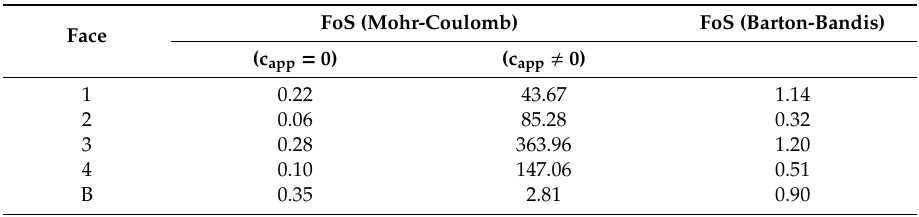
Table 9. FoS values obtained considering the presence of seismic action with respect to planar sliding mechanism.